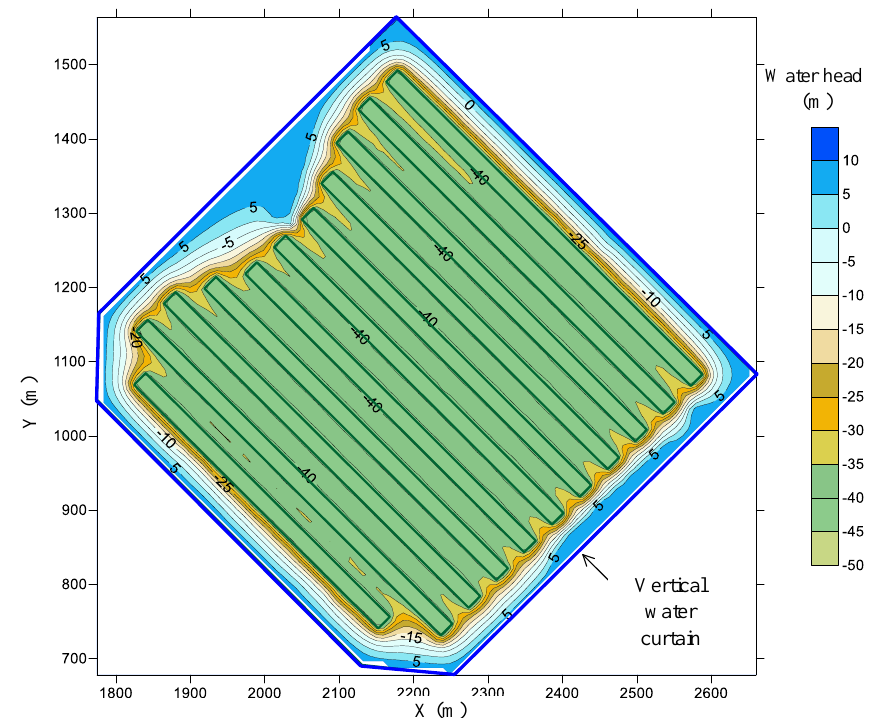
Figure 20. Water head contour at the cavern bottom after 50 years of operation.